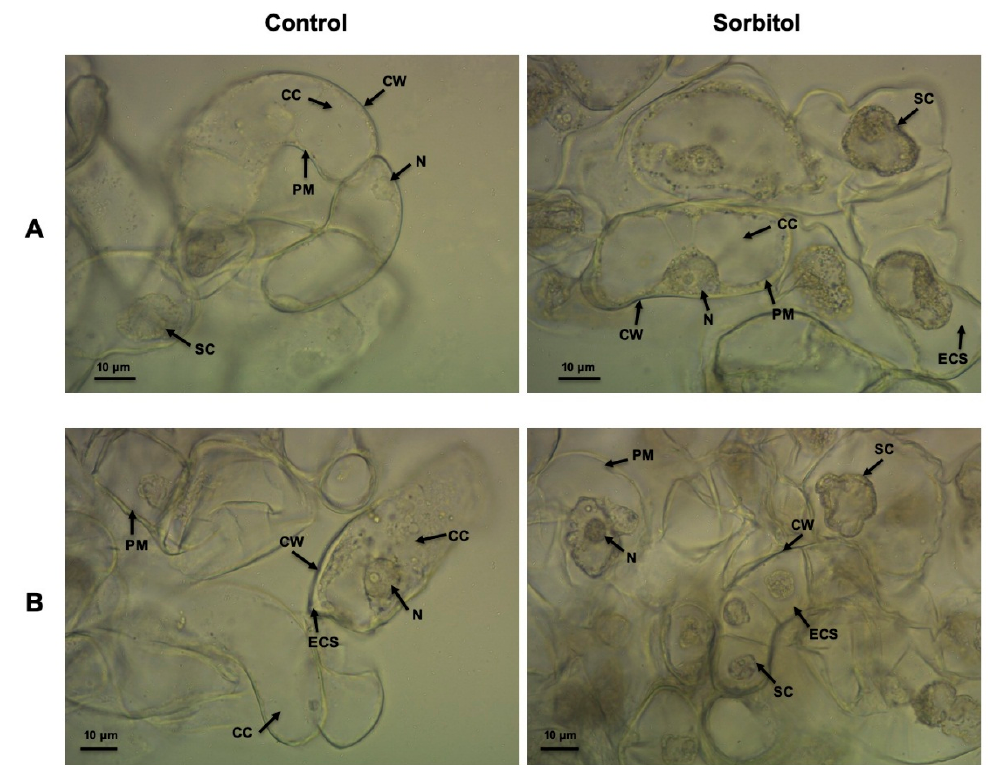
Figure 6. Light microscopic analysis of sorghum cell cultures following osmotic stress treatment. ( A ) ICSB 338 cells following 72 h osmotic stress. ( B ) White sorghum cells following 72 h osmotic stress. Eight-day old cell cultures were treated with distilled water (controls), and 400 mM sorbitol (treated) for 72 h. Microscopic images were taken using a fitted light microscope DeltaPix digital camera at a magnification of 40 × . CW indicates cell wall; ECS, extracellular space; PM, plasma membrane; CC, cytoplasmic contents; N, nucleus; and SC, compressed cytoplasm. The scale bar is 10 μ m.